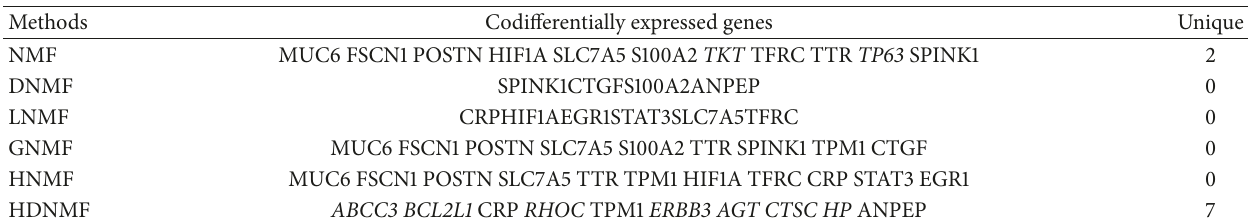
Table 6: Co-differentially expressed genes of five methods (INTA